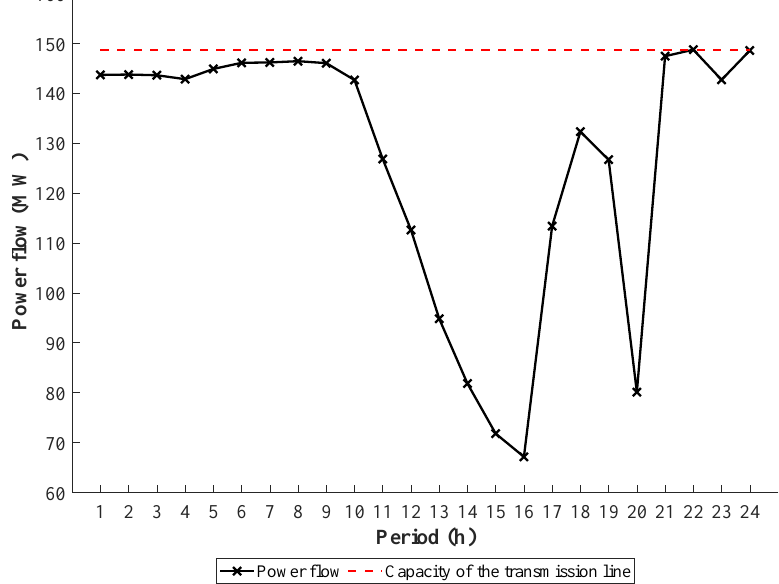
Figure 11. Power flow at transmission line 11 in Case